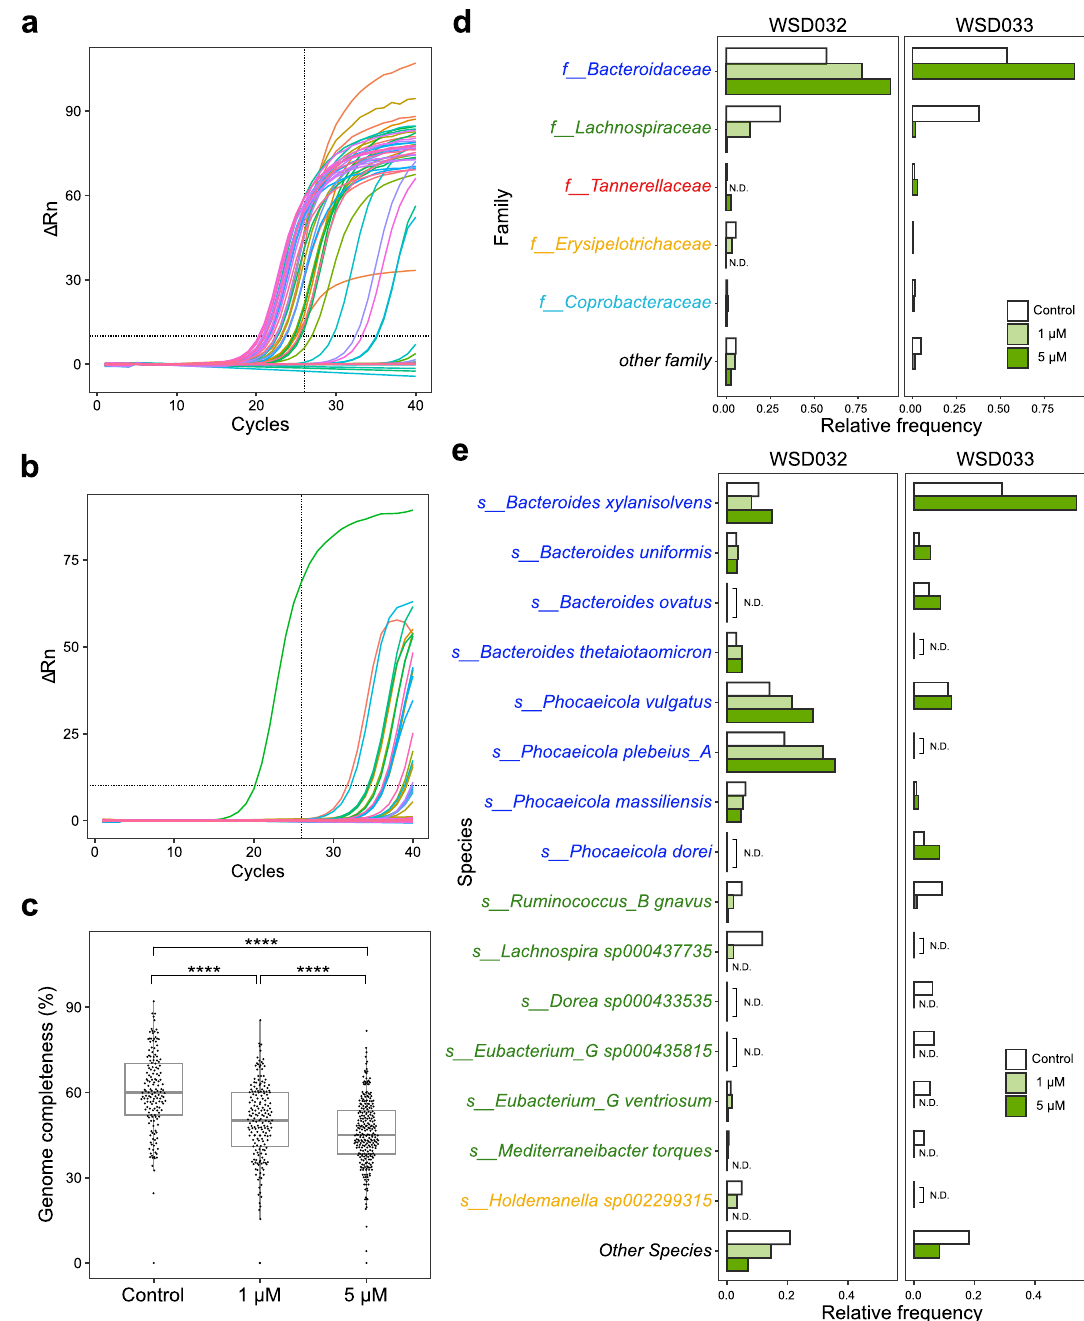
Figure 4. Single-cell sequencing of viable bacteria from human feces. ( a , b ) Detection of E. coli SAGs in spiked fecal samples via qPCR. Heat-killed E. coli cells were spiked into human feces-derived bacterial cells and then processed without ( a ) or with ( b ) PMA treatment, followed by SAG-gel. Crosshairs show thresholds for the positive amplification of E. coli DNA. All values were assessed for subject WSD033. ( c ) Genome completeness of human fecal bacteria SAGs obtained using PMA-SAG-gel with two PMA concentrations (1 μM and 5 μM). Control means no PMA treatment. ****p < 0.001 (Wilcoxon rank-sum test). All values were assessed for subject WSD032, and SAGs with < 1 Mb reads were removed. ( d , e ) Detected bacterial composition at the family level ( d ) and species level ( e ) in two fecal samples, WSD032 and WSD033, treated with PMA (N.D. not detected). The family and species names are colored according to family name. Other families or species accounted for less than 1.1% or 1.0%,